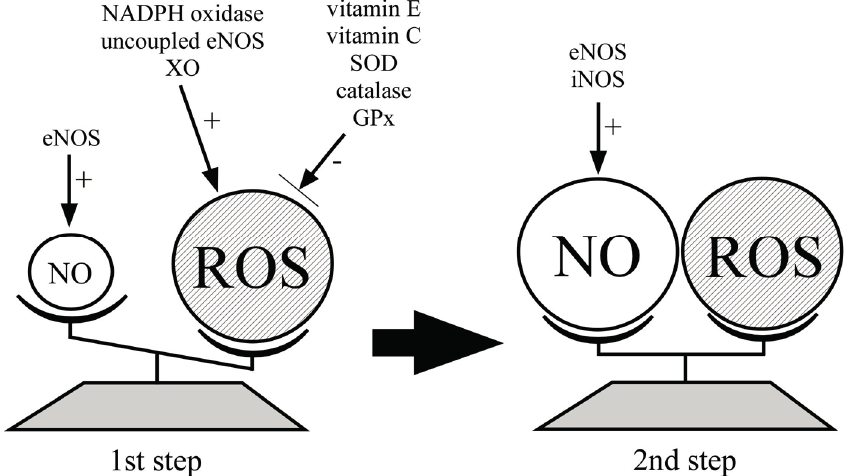
Figure 2. The balance between NO and ROS in the pathogenesis of PE. ROS production is increased and NO production is decreased in the peripheral blood and placenta derived from women who subsequently develop PE at the first step. Both ROS and NO production are increased in women with PE at the second